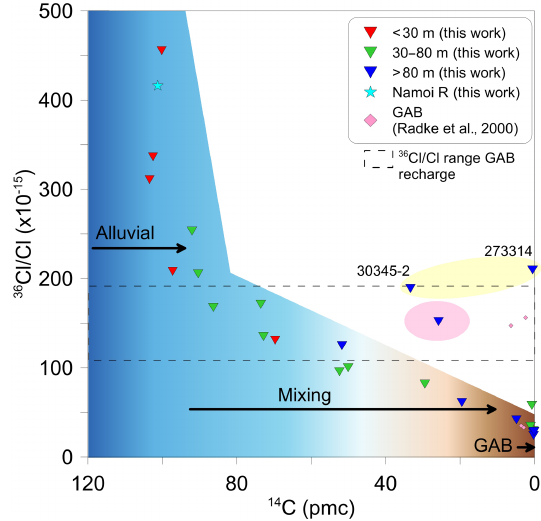
Figure 6. 3 H (TU) vs. 14 C (pmc). This shows the mixing between groundwater with quantifiable 3 H activity (as indicated by the red band) and groundwater with very low 14 C content (as indicated by the dotted blue line).